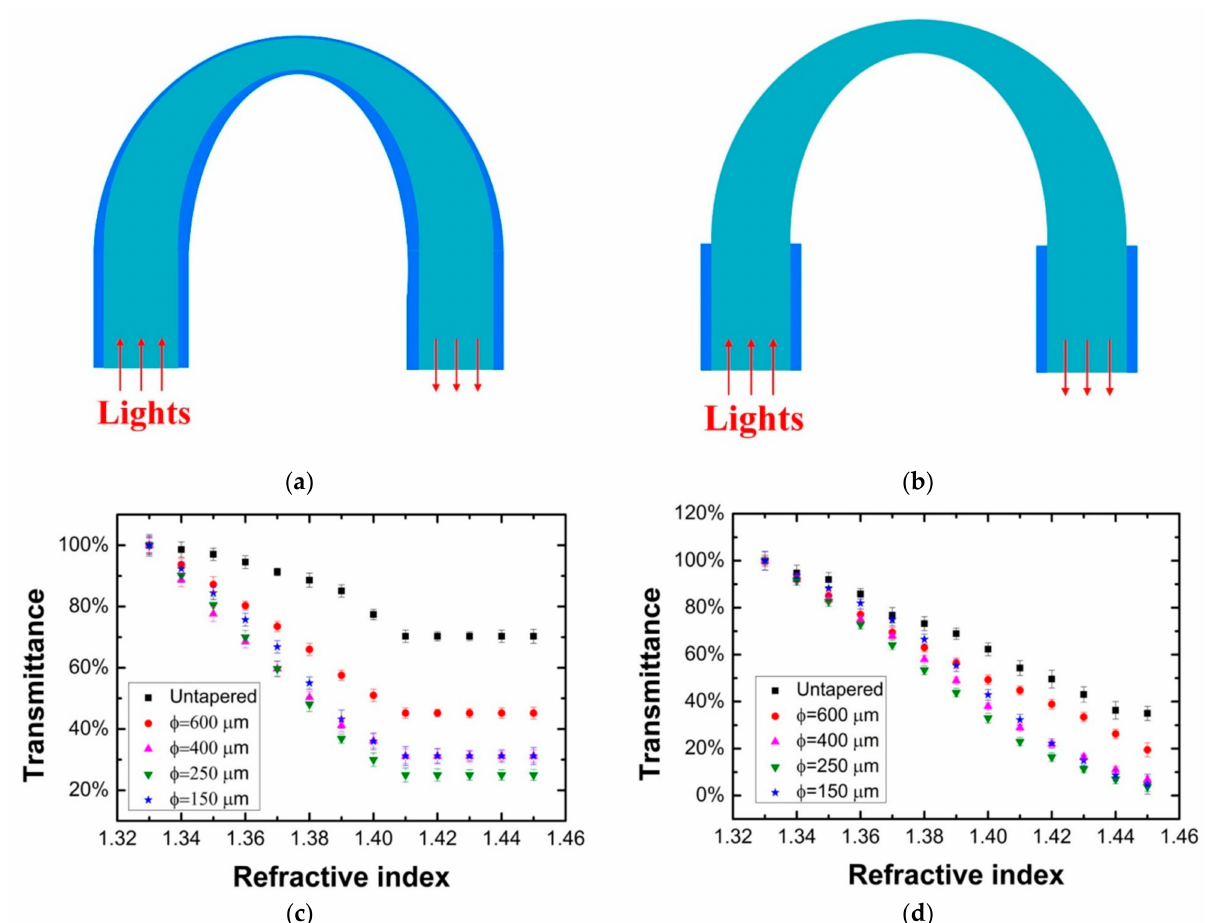
Figure 8. The schematic illustration of the macro-bending tapered POF probes with ( a ) and without ( b ) cladding, and the RI sensing performance for the probes with ( c ) and without ( d ) cladding [87]. Jing et al. [90] proposed a side-polished, macro-bending POF for RI sensing as shown in Figure 9. By changing the curvature radius, the polished depth, and the polished position (angle), the RI sensing performance of the probe was optimized. They obtained the maxi- mum RI sensitivity of 154 dB/RIU in the RI range of 1.33–1.44 when the curvature radius, the polished depth, and the polished position were 5 mm, 500 µ m, and 60 ◦ , respectively. The influence of the temperature was also tested by the same group [91]. Wang et al. [92] demonstrated a U-shaped, double-sided, polished POF for RI sensing. They optimized the processing parameters experimentally, and a sensitivity of 1541%/RIU was obtained with a resolution of 5.35 × 10 − 4 in the scope of 1.33–1.39. Besides, Zhong et al. [93] explored the temperature-independent operation of a POF-based evanescent wave sensor immersed in distilled water. They observed that the light transmission modes and sensitivity of the sensor were affected by changes in the surface morphology, diameter, and RI of the sensing region caused by changes in temperature. The transmitted light intensity of the sensor was maintained at a constant level after five cycles of the heating–cooling treatment, after which the fibers exhibited a smooth surface, low RI, and large fiber